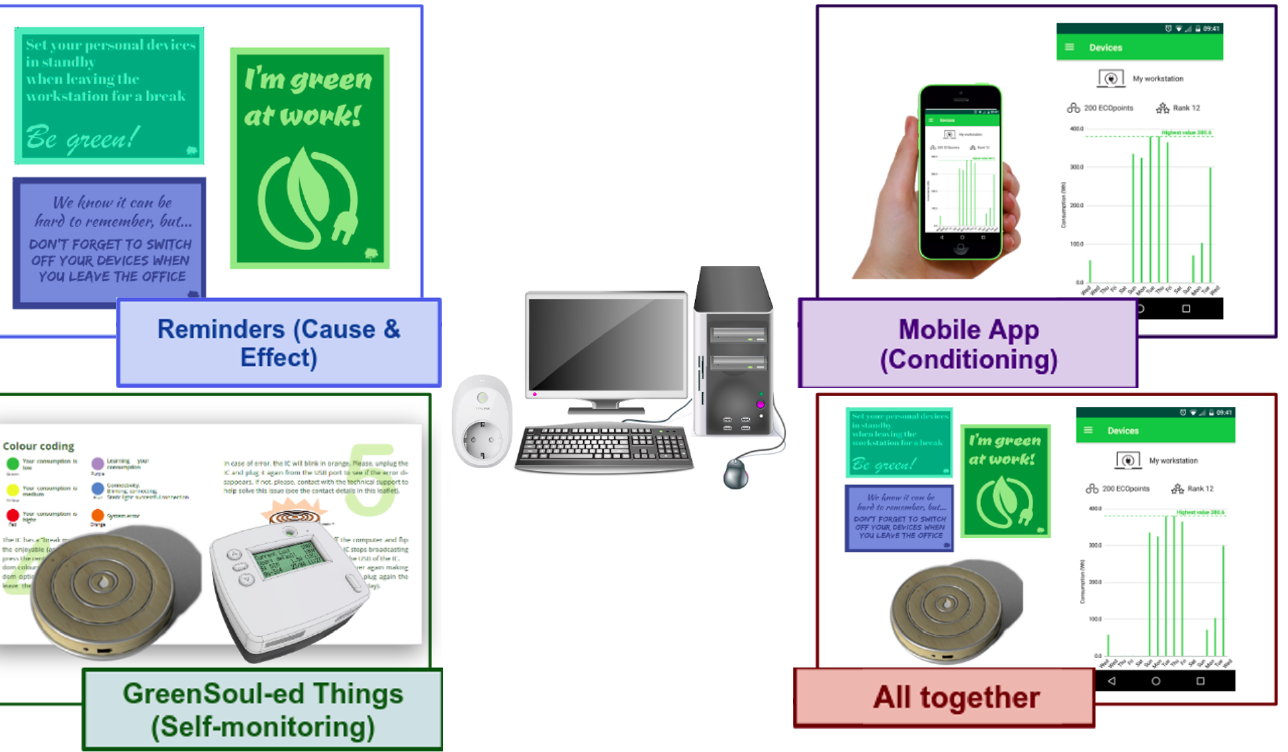
Figure 4. The GreenSoul Persuasion Treatments with the associated technology to deliver them (post-its, mobile app, physical devices and all the treatments together)